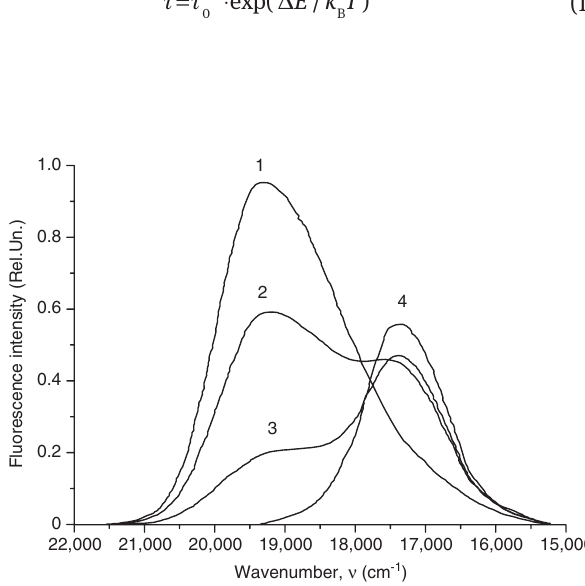
Figure 1 Fluorescence spectra of ternary complex